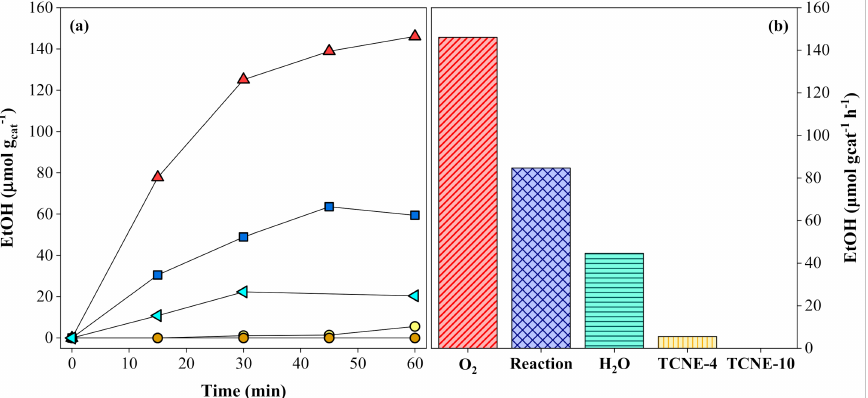
Figure 10. Evolution of the ( a ) ethanol production from CO 2 and C 2 H 6 as a function of photoreaction’s time and the respective ( b ) reaction rate (for the maximum production), in the absence ( ) and the presence of electron scavengers: 4 ( ) and 10 ( ) µ mol of TCNE; 0.2 mmol of O 2 ( ); or 0.3 µ mol of H 2 O ( ). Experimental conditions: 20 mg of SrTiO 3 :RuO 2 :NiO; [Ru]:[Ni] = 1:1 (molar); Ru = 0.8 wt. %; P C = 1.01 bar; P CO = 0.35 bar; T = 200 ◦ C and I = 1000 W m -2 2 H 6 2